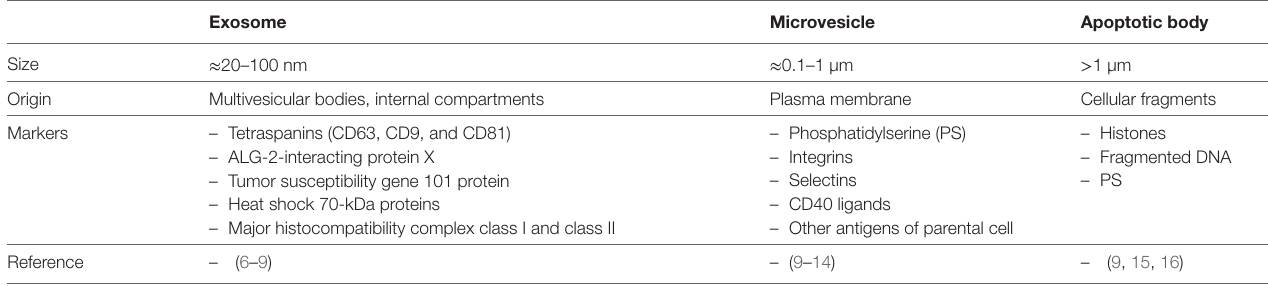
TABLe 1 | Characteristics of extracellular